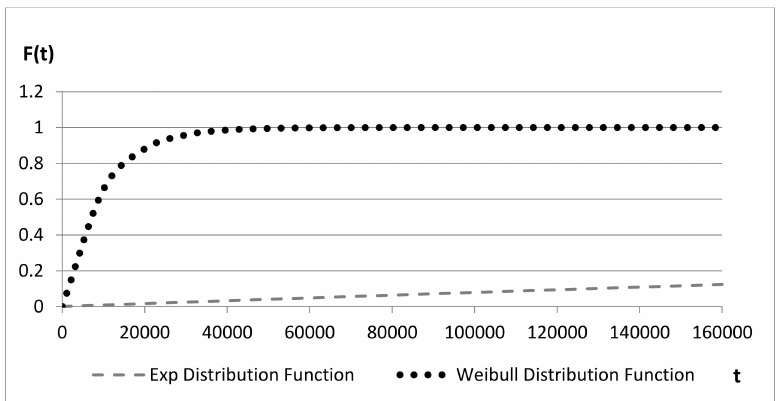
Figure 8. Comparison of cumulative distribution functions F ( t ) for Prj1.